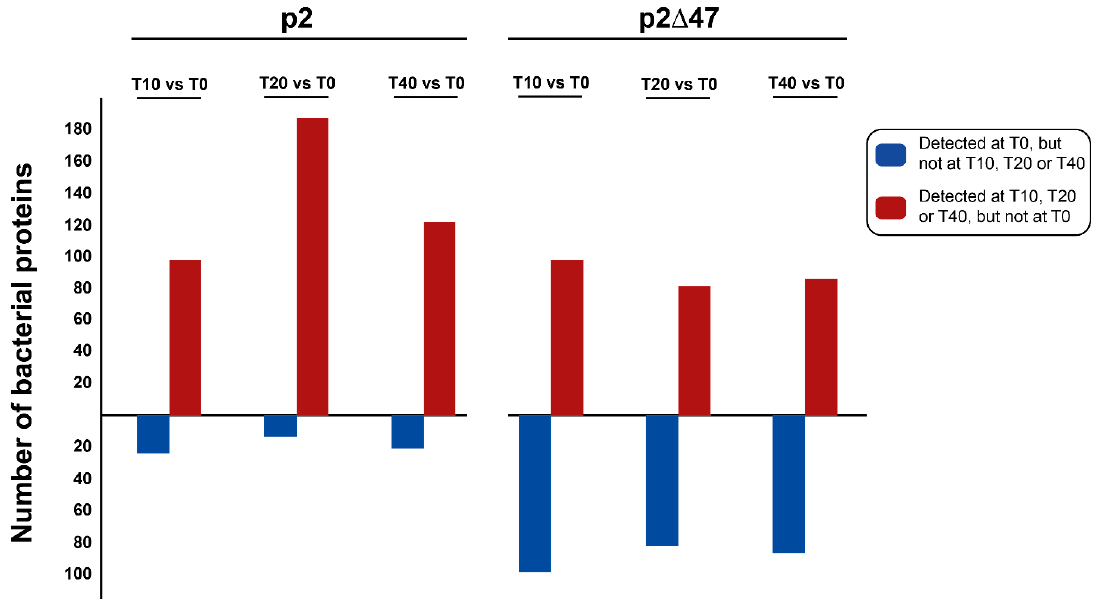
Figure 7. Bar graph depicting the number of bacterial proteins detected only in uninfected cultures (dark blue) or only during infection (dark red). The number of proteins is indicated on the y -axis. There are significantly more genes that are induced than genes that are inhibited by phage p2 infection ( left ). In comparison, there are fewer genes induced, and more genes inhibited following phage p2 ∆ 47 infection ( right ).